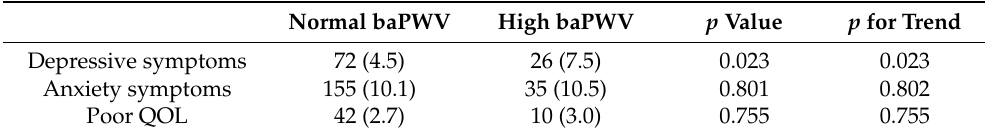
Table 2. Trend analysis of depressive and anxiety symptoms and poor quality of life in normal and high baPWV groups. Normal baPWV High baPWV p Value p for Trend Depressive symptoms 72 (4.5) 26 (7.5) 0.023 0.023 Anxiety symptoms 155 (10.1) 35 (10.5) 0.801 0.802 Poor QOL 42 (2.7) 10 (3.0) 0.755 0.755